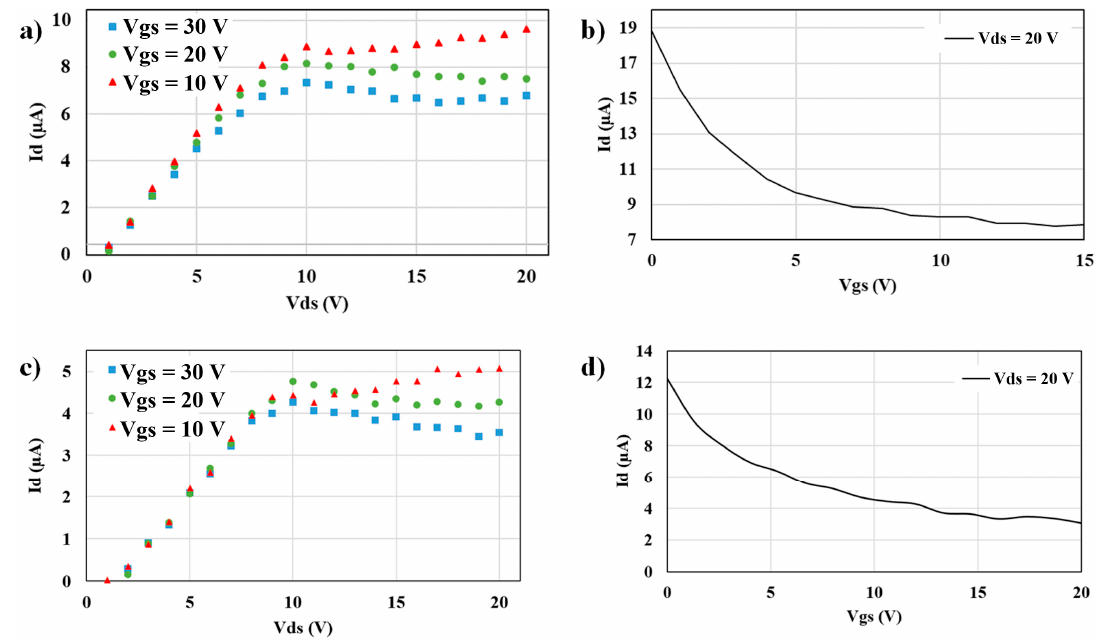
Figure 3. ( a , c ) Output and ( b , d ) transfer characteristics of the fabricated flexible photo-transistor ( a , b ) under light and ( c , d ) in dark.